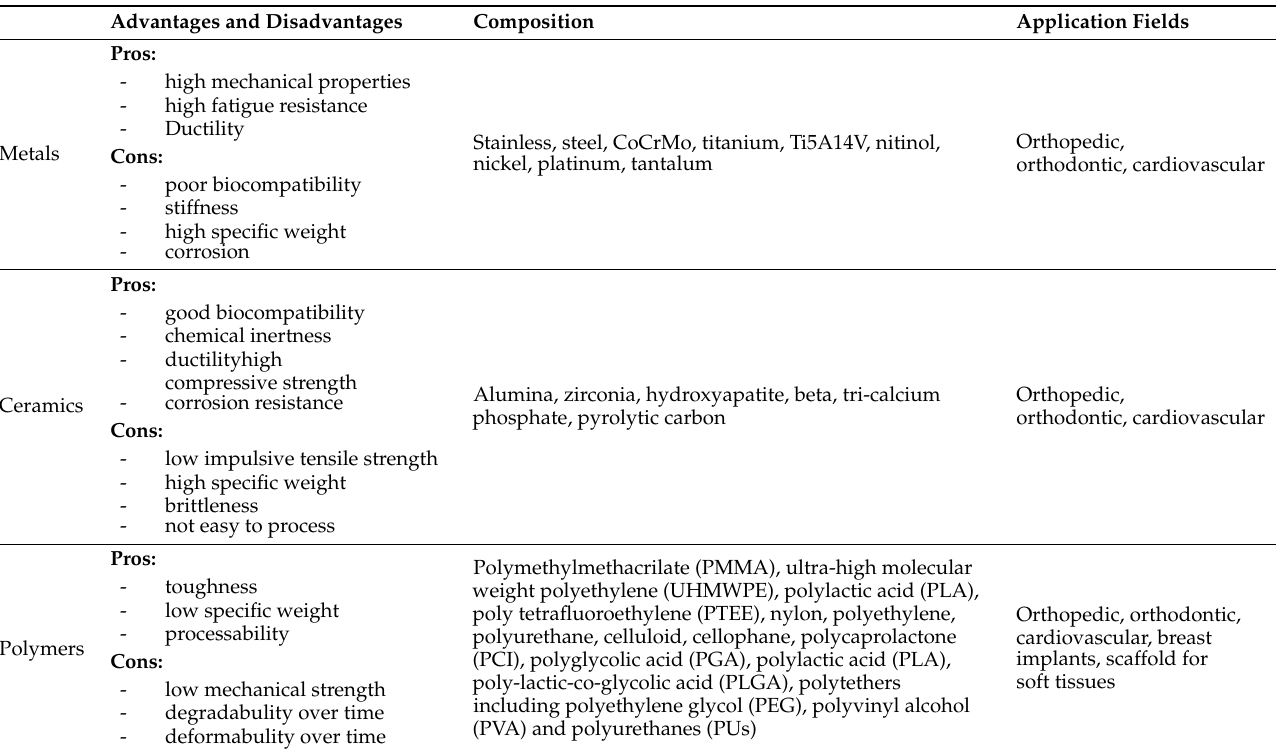
Table 1. Leading biomaterials, their properties, chemical compositions, and